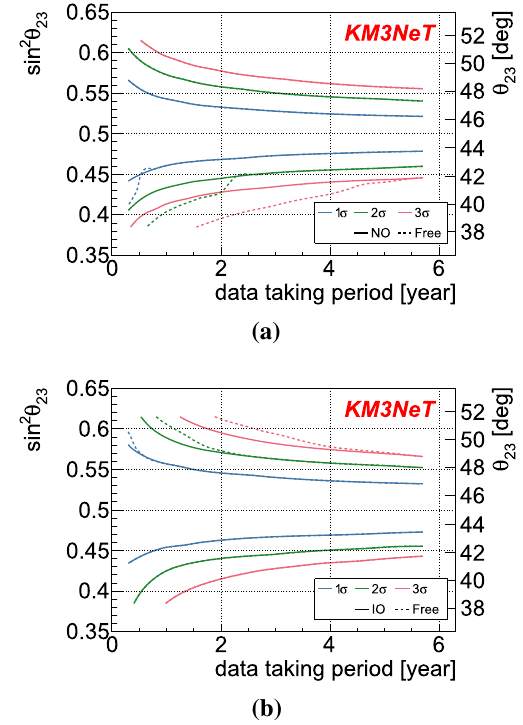
Fig. 11 Expected sensitivity to determine the θ 23 octant at 1 (blue), 2 (green) or 3 σ (red) as a function of data taking time for both NO ( a ) and IO ( b ) assuming the true NMO is known (solid line) or unknown (dashed line). The dashed lines differ from the plain ones when the